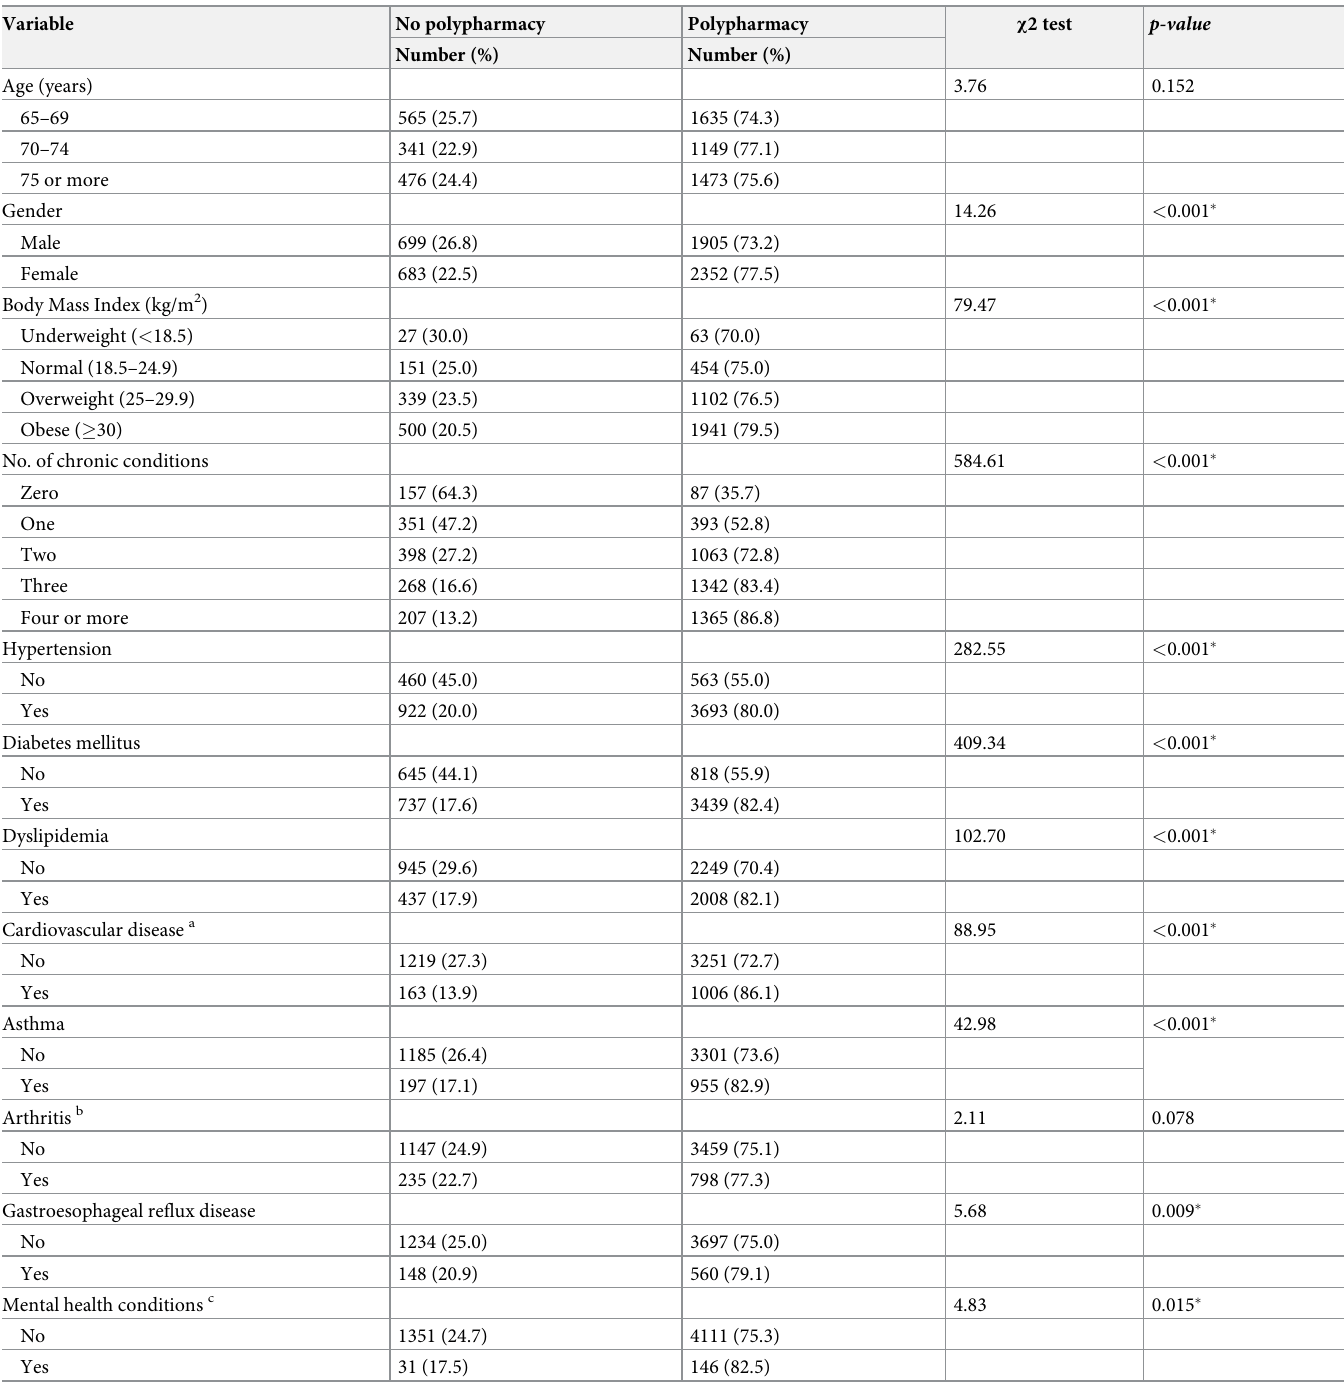
Table 4. Bivariate association between explanatory variables and polypharmacy status (N =